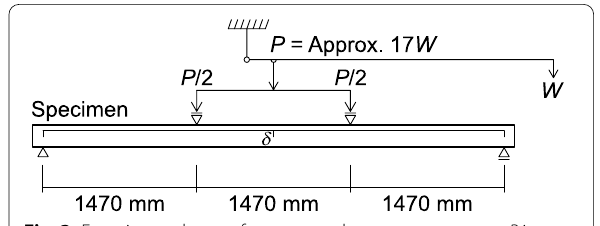
Fig. 3 Experimental setup for creep and creep rupture tests. P is load, W is suspended weight at the end of the moment arm, and δ is displacement at a neutral axis of the specimen at span center